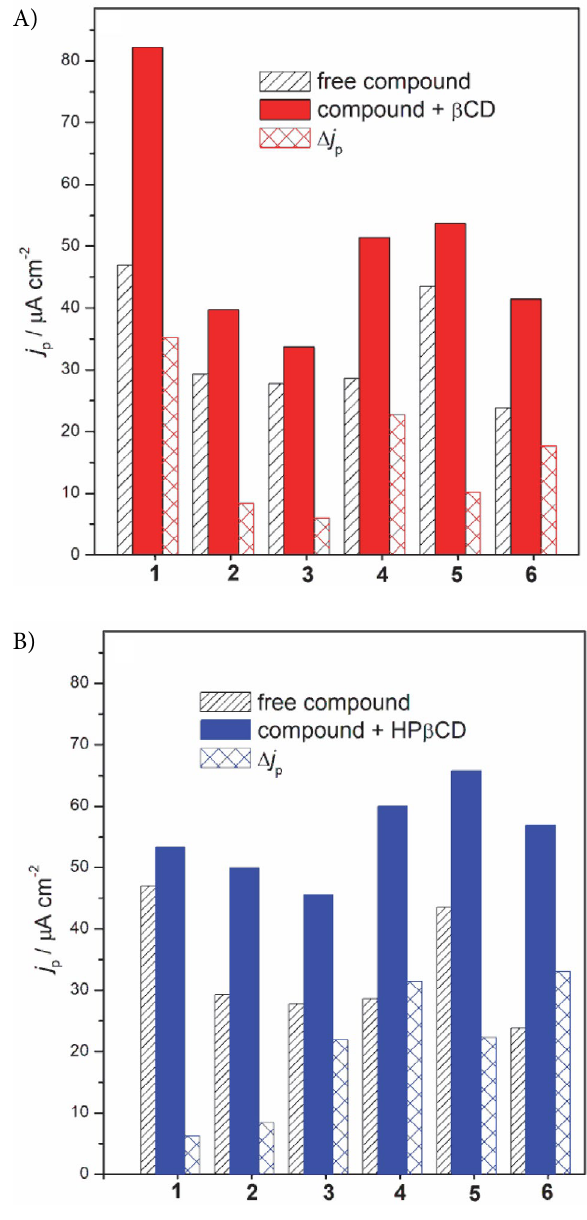
Figure 6 . Bar plots of the peak current densities obtained by the oxidation of the free succinimides and their inclusion complexes with βCD (A) and HPβCD (B) derived from Fig. 5 and their differ- ence (network grid